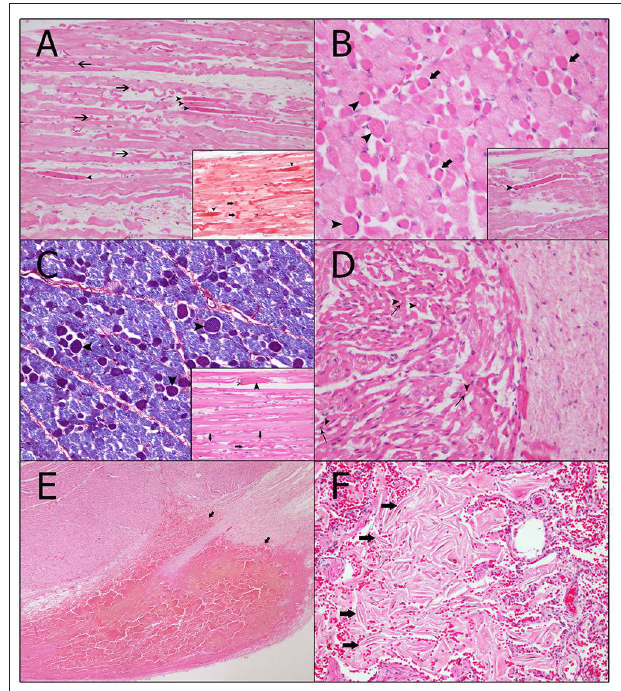
FIGURE 2 | Vascular and acute degenerative changes observed in the skeletal and heart muscles. (A) Long and thin undulated fibers, also referred to as wavy fibers (arrows), can be seen in the myocytes. In addition, the myocytes demonstrate hypereosinophilia, i.e., an increase in staining of necrotic muscular cells (arrow heads) with different histochemical techniques, which is usually associated with segmental hypercontraction (arrow heads) (hematoxylin and eosin technique, magnification: 40 × ). Inset: The contraction band necrosis (arrows) runs transversely throughout the myocytes and is identified via the increasing red color intensity (Masson’s trichrome technique). Furthermore, both hypereosinophilia and wavy fibers can be observed (thin arrows) (magnification: 40 × ). (B) In the transversal cut, myocytes of minor caliber (most likely type I fibers) are affected and present hypereosinophilia with segmental hypercontraction (arrow heads). Moreover, endomysia edema (thin arrows) can be seen (hematoxylin and eosin technique, magnification: 60 × ). Inset: Detail of the segmental hypercontraction of a myocyte (hematoxylin and eosin technique, magnification: 40 × ). (C) More intense blue coloring of the damaged myocytes of minor caliber, which identifies hypereosinophilia and segmental hypercontraction (arrow heads) (phosphotungstic acid hematoxylin technique, magnification: 40 × ). Inset: Detail of a myocyte with segmental hypercontraction (arrow head) and segmental necrosis of the fiber with the retraction cap (thin arrow). Wavy fibers can also be observed (arrows) (hematoxylin and eosin technique, magnification: 40 × ). (D) Cardiomyocytes show vacuolar degeneration (arrow heads) and pyknotic nucleus (thin arrows) (hematoxylin and eosin technique, magnification: 40 × ). (E) Vascular changes present in the heart consistent with a subepicardial hemorrhage in the left ventricle (arrows) (hematoxylin and eosin technique, magnification: 4 × ). (F) Detail of the intra-alveolar keratin spicules (arrows) (hematoxylin and eosin technique, magnification: 40 × ).